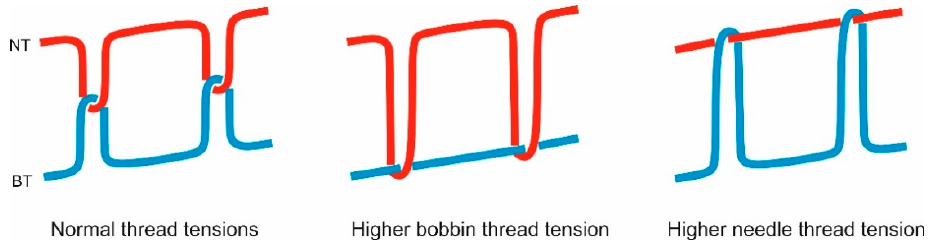
Figure 8. Influence of the pre-tension of thread systems on the position of crossing points in a double lockstitch seam; needle thread (NT) in red, bobbin thread (BT) in blue.